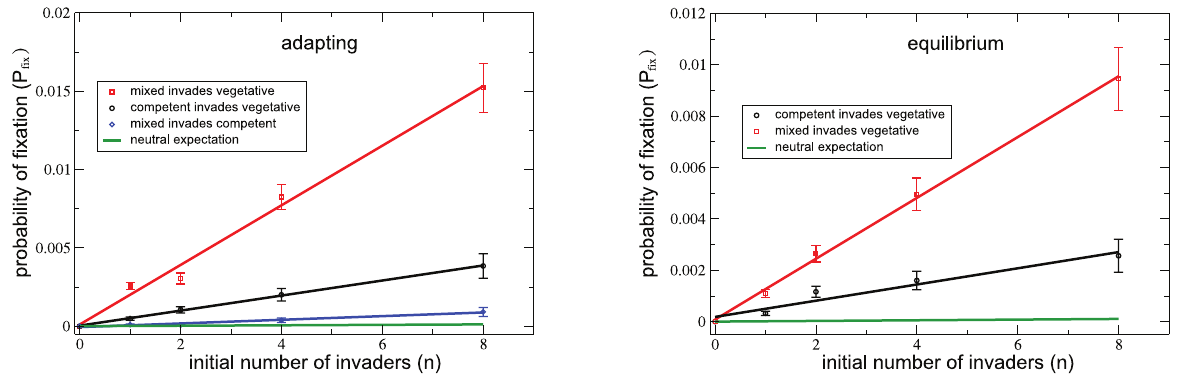
Figure 5. Mixed populations are competitively superior to purely competent ones, both during adaptation (left) and at mutation/ selection/drift equilibrium (right). When invading vegetative residents during adaptation, each stochastically switching cell leaves an average of & 136 descendants: 4 times as many as competent invaders. Likewise, under equilibrium conditions, each stochastically switching cell leaves an average of & 101 descendants: again, 4 times as many as competent invaders. Mixed populations are also able to directly invade competent residents during adaptation (blue diamonds, left) but not at equilibrium. The linear increase suggests that frequency-dependent selection is not operating (see main text). The neutral expectation represents P fix ~ n = N o , where N o is the number of cells present at the beginning of competitions. N o & 71,000 (left) and N o ~ 77,556 (right). Error bars denote one standard error. Each data point was derived from a number of replicate competitions greater than 10,000/(initial # invaders). Solid lines are the least squares linear fit. ‘‘Stochastically switching’’ populations had s in ~ s out ~ 0 : 033 , r = l ~ 10 { 2 ). All other parameters are the same as above. Using 100 -fold smaller mutation rates results in similar qualitative behavior for the adaptive case (left), and is explored in figure